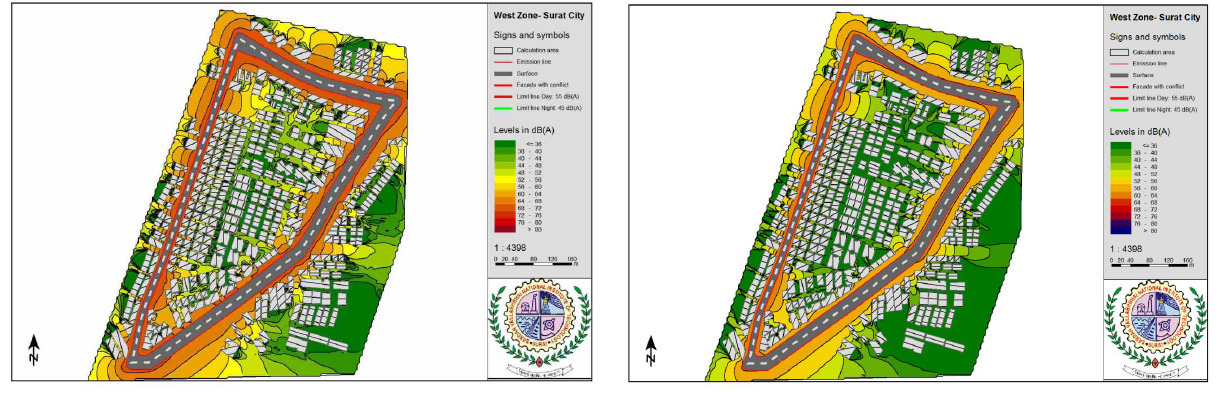
Figure 8: Daytime noise map of West zone using RLS-90